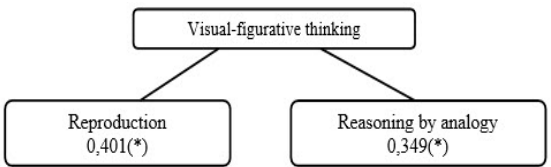
Figure 10. Correlation of visual-figu - rative thinking, indicators of forecasting and verbal-logical thinking in preschool children Visual-figurative thinking correlates positively with the indicator of verbal-logical thinking “reasoning by analogy” (r = 0,349, when ≤0,05) and the indictor of ability to predict “reproduction” (r = 0,401, when ≤